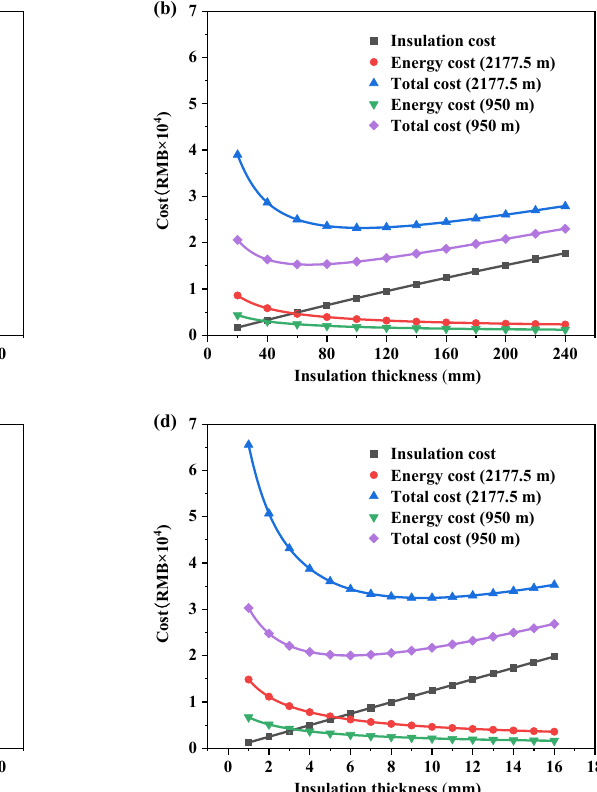
Figure 8. Variation of cost with insulation thickness ( a ) RW; ( b ) XPS; ( c ) PU; ( d ) HVIP. The minimum total life cycle cost of the four insulation materials and the correspond- ing insulation thickness for each year from 1 to 20 years were calculated, and, the variation of economic thickness and total cost with service life are presented in Figure 9. It can be seen that the service life of CH has a significant effect on economic thickness and total life cycle cost whose values increase with the length of the service life, showing a trend of rapid increase and then slow growth, which is consistent with the results in